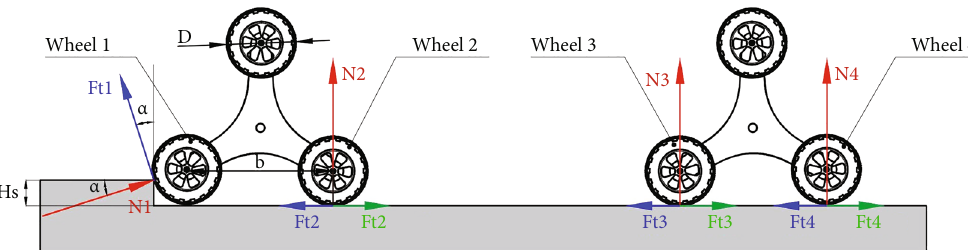
Figure 6: Mechanical analysis of a single planetary wheel in the case of vertical